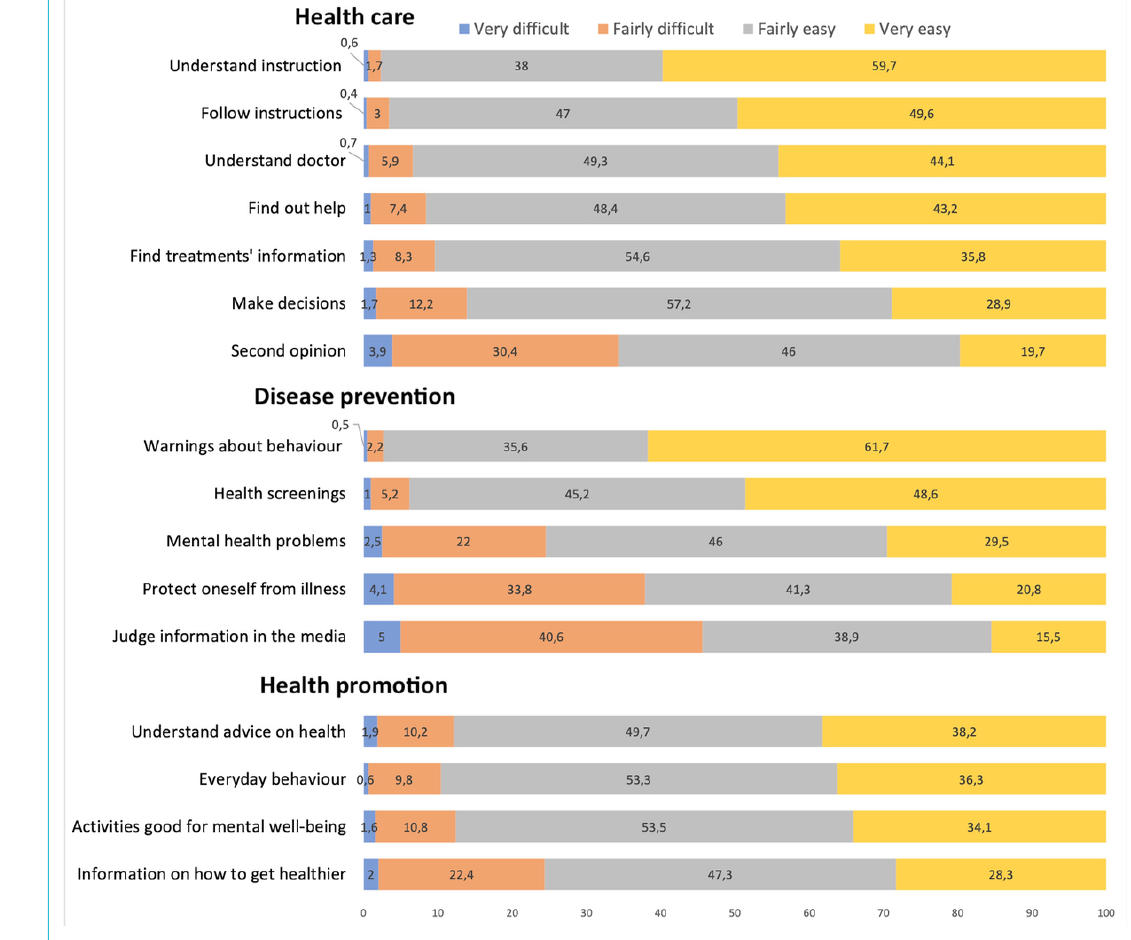
Figure 2: Short version of the European Health Literacy Survey questionnaire (HLS-EU-Q16), percentage of respondents per categories, adults aged 58+, SHARE Switzerland, 2019/2020, n =